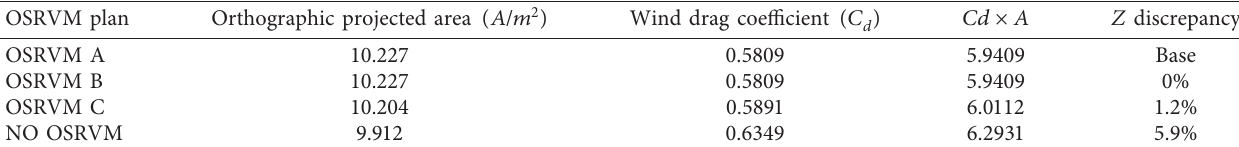
Table 5: Comparison of the aerodynamic performance of four rear-view